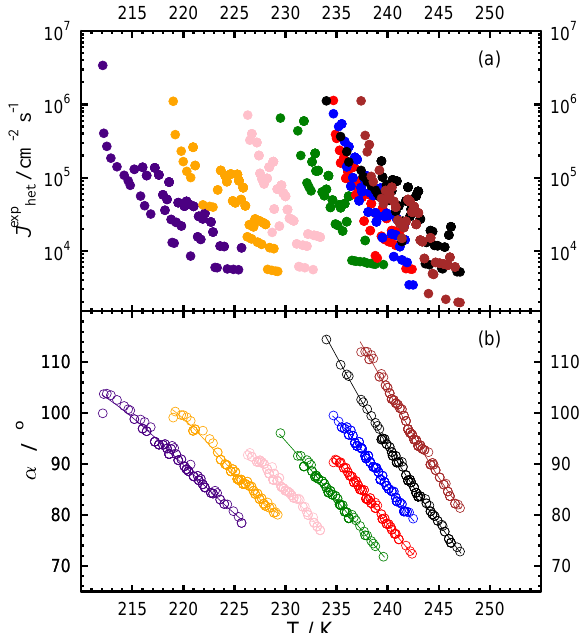
Fig. 3. (a) shows experimentally derived heterogeneous ice nucle- , and (b) corresponding contact angles, ation rate coefficients, J exp het α , of Pahokee peat/water and aqueous Pahokee peat/ ( NH 4 ) 2 SO 4 droplets shown as a function of temperature and a w . Brown, black, blue, red, green, pink, orange, and purple squares represent the ini- tial a w of 1.00, 0.981, 0.964, 0.947, 0.926, 0.901, 0.883, and 0.862, respectively. Lines indicate a third-order polynomial